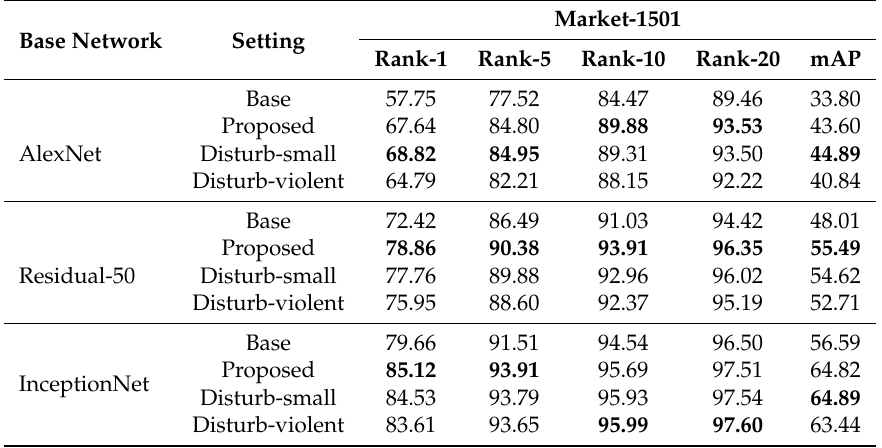
Table 6. Identification accuracy (%) and mAP (%) of the proposed method with different base networks on Market-1501 when different disturbances are applied to the segmented body parts. The best results under different settings are marked in bold.